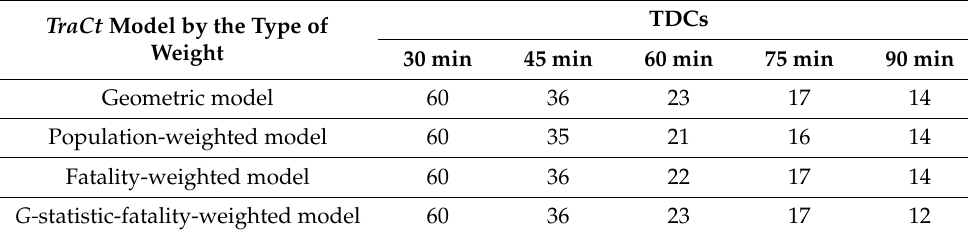
Table 1. Number of facilities chosen as solutions by different objectives.